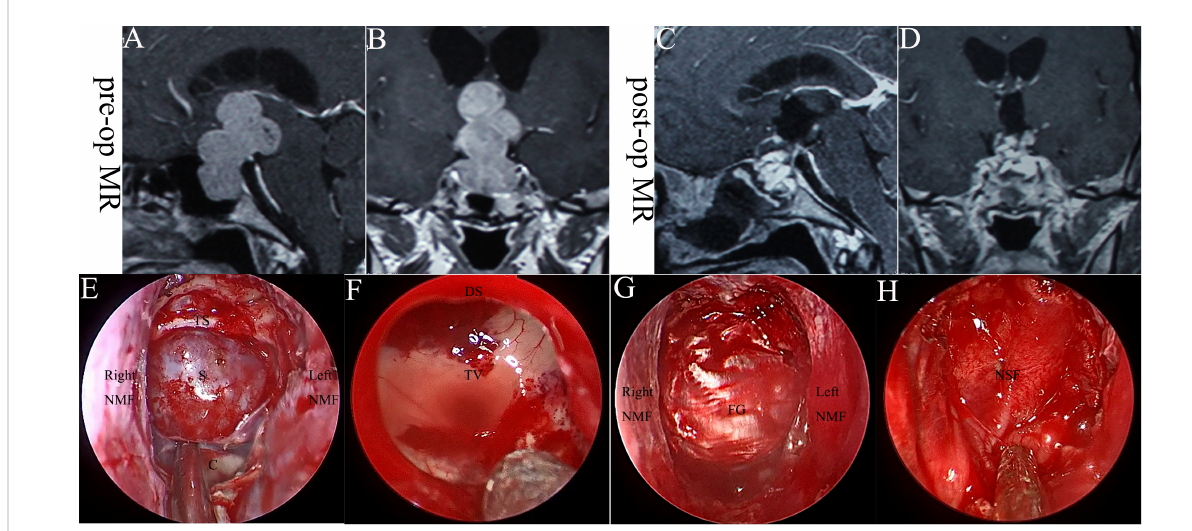
FIGURE 3 The case with high- fl ow CSF leak was reconstructed with a nasoseptal fl ap. (A, B) . Pre-operative MRI scanning. (C, D) . Post-operative MRI scanning. (E – H) . Intraoperative images. S, sella; C, clivus; TS, tuberculum sellae; NMF, nasoseptal mucosal fl ap; DS, diaphragma sellae; TV, the third ventricle; FG, fascial graft; NSF, nasoseptal fl ap.